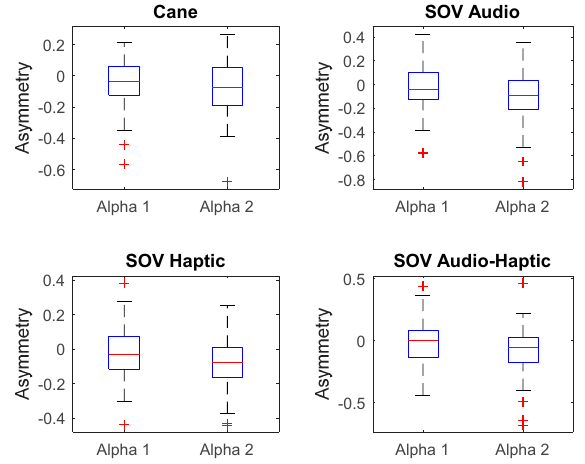
Figure 23. The average of the alpha1 asymmetry for all the users.